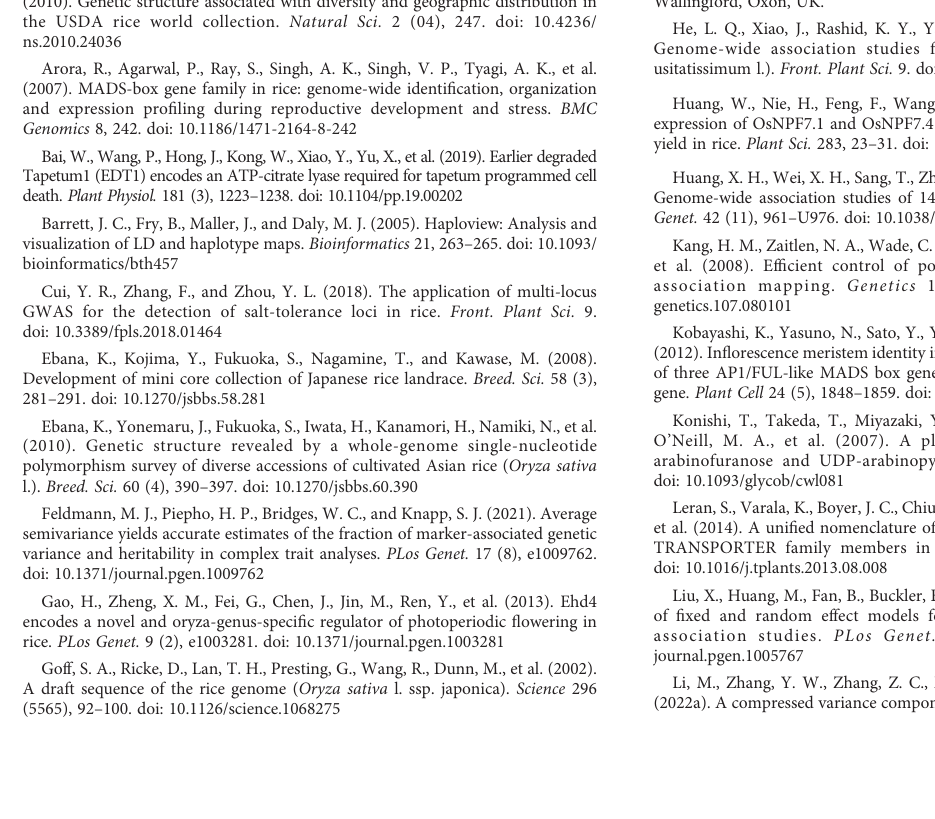
SUPPLEMENTARY FIGURE 2 Manhattan plots of the multi-environment analysis for the fl owering time of rice. (A, B) Manhattan plots of QTNs and QTN- by-environment interactions for all populations. (C – L) Manhattan plots of QTNs and QTN-by-environment interactions for each subpopulation. Pink text: known genes for the corresponding signi fi cant/suggested SNPs.